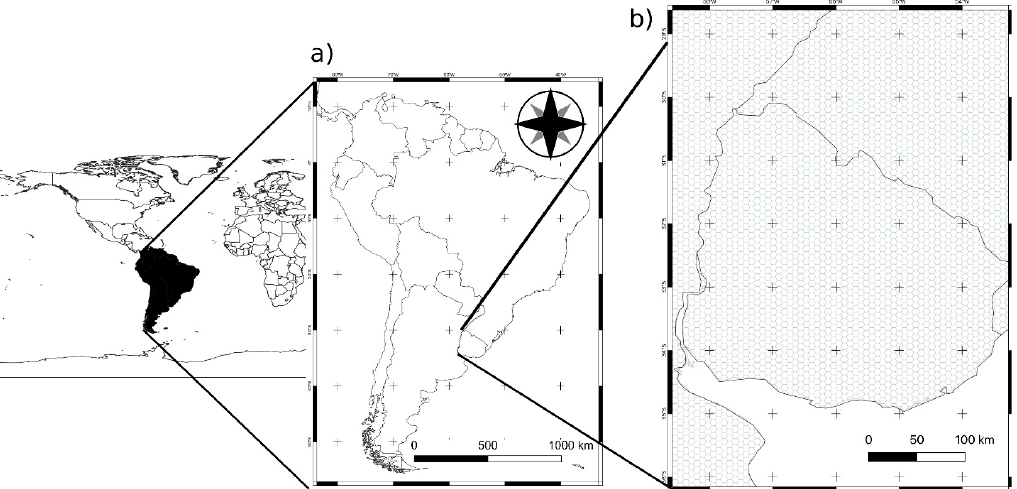
Figure A1. Global study area context. ( a ) South America in the global context. ( b ) An amplified map showing the resolution of the grid composed of hexagons of approximately 6 km of apothem. Table A2. Assessments of favourability models for the five species of Paspalum , according to discrimination and classification parameters. Abbreviations: AUC, area under the ROC (receiving operating characteristic) curve; CCR, correct classification rate; TSS, true skill statistic.